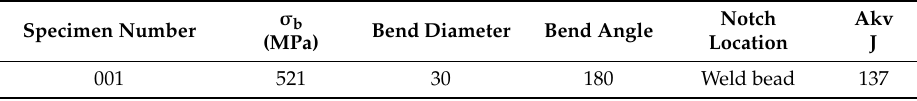
Table 4. Welding experimental result.